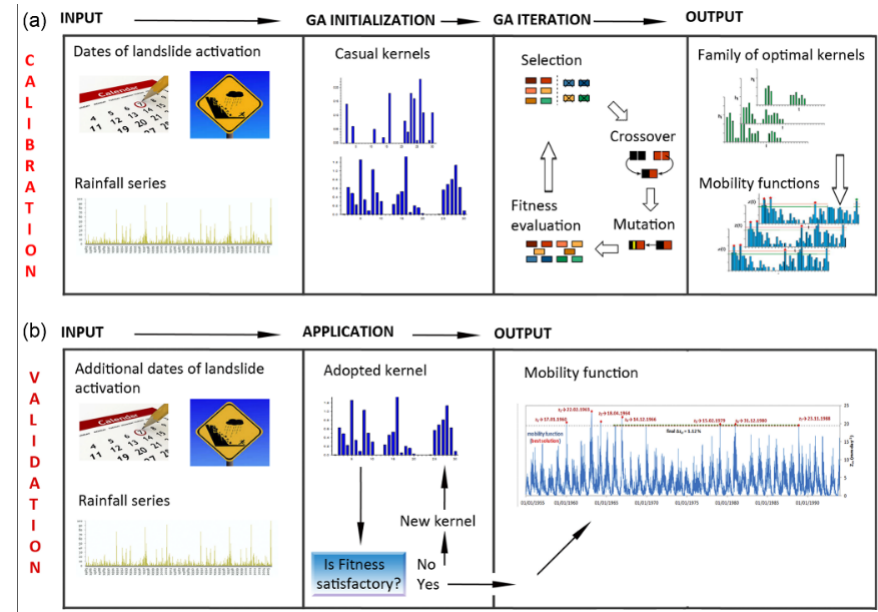
Figure 1. Schematic sketch of: ( a ) the calibration and ( b ) the validation procedures of GA SAKe .